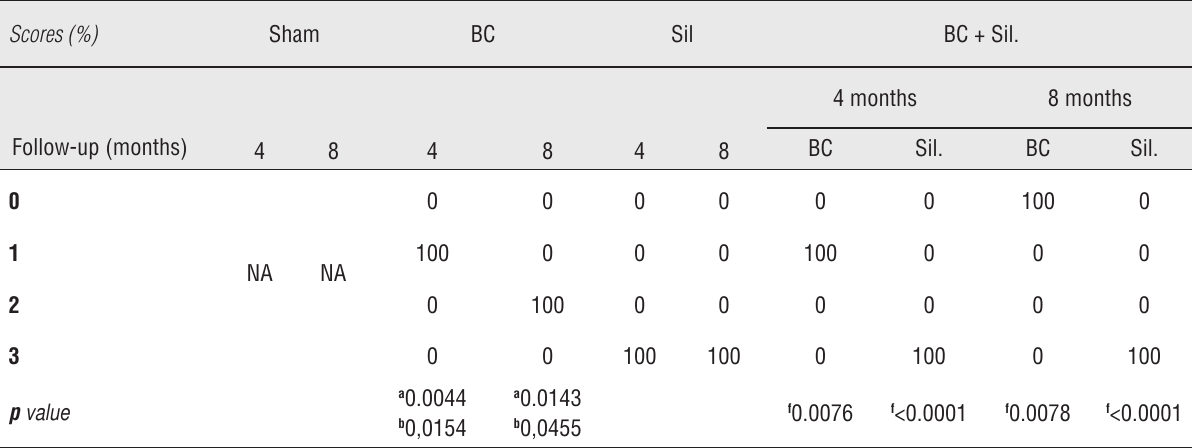
Table 2. Deposition of the Collagen in Periurethral